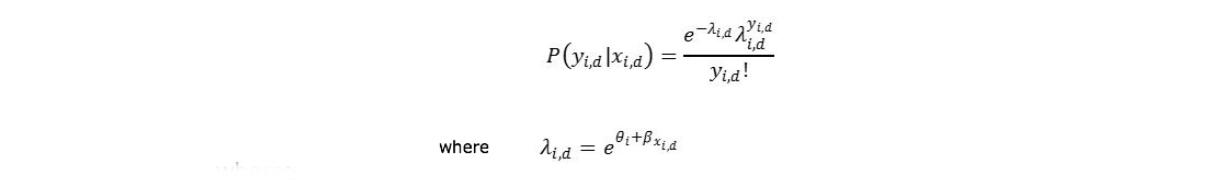
Figure 2. Self-controlled case series (SCCS) density equation.